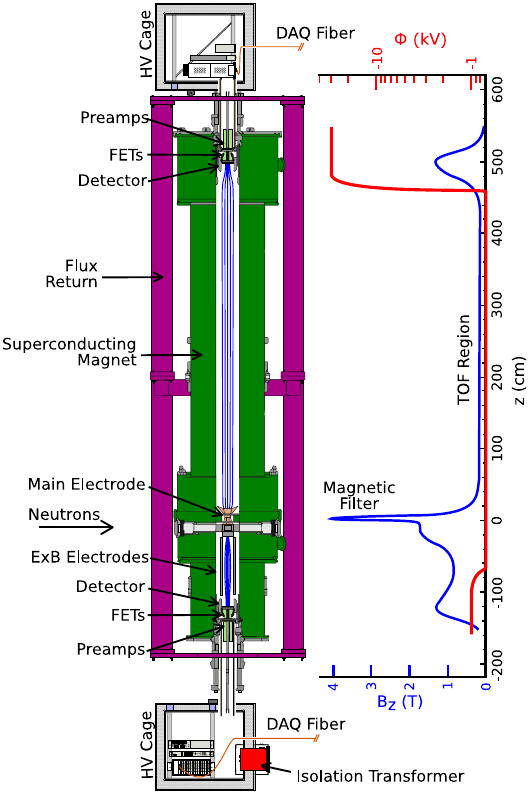
Figure 2. A diagram of the Nab spectrometer with details of the electronics, detector system, electrodes, and electric and magnetic field